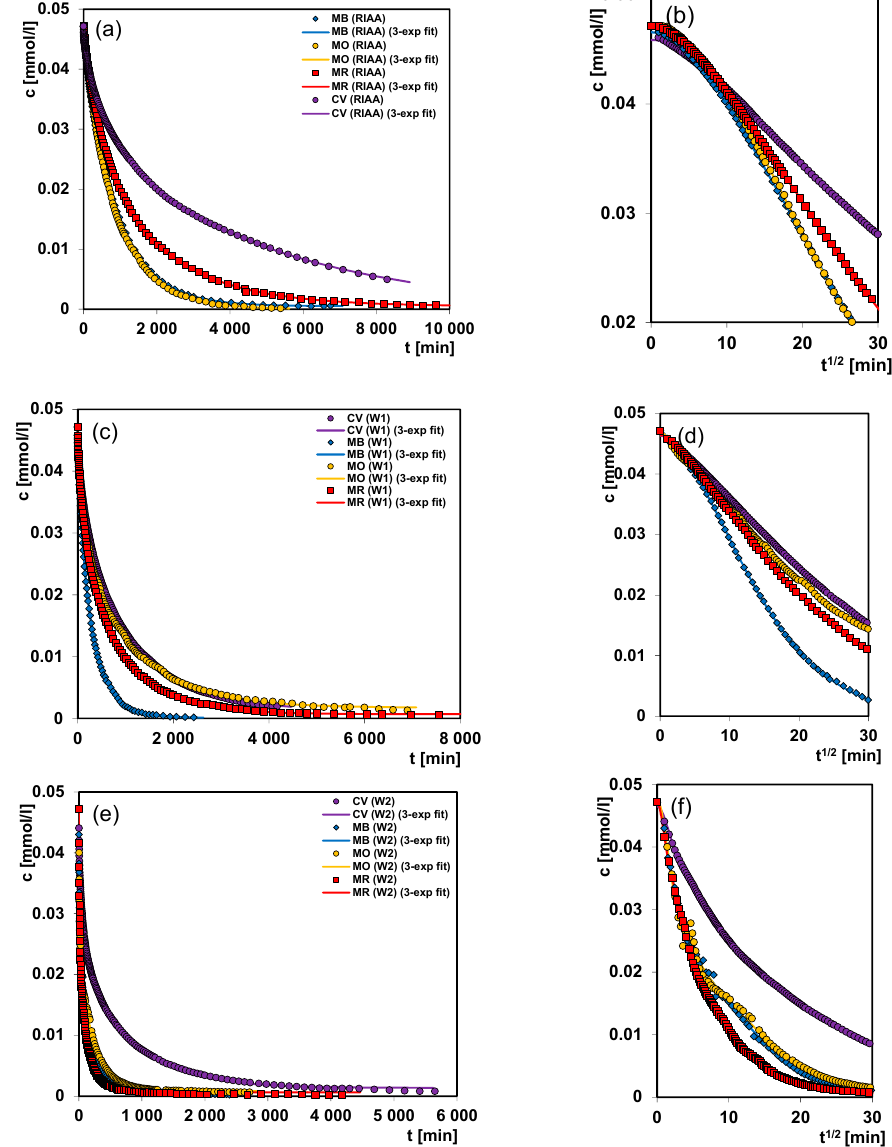
Figure 9. Comparison of the adsorption kinetics for various dyes on the carbonaceous materials RIAA ( a , b ); W1 ( c , d ); W2 ( e , f ) at the coordinates: relative concentration ~ time and relative concentration ~ square root of time. The lines correspond to the fitted multi-exponential equation.